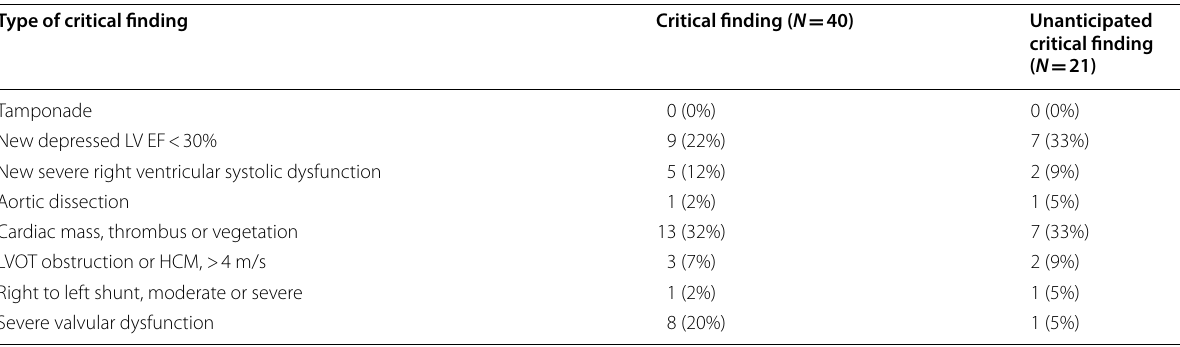
Table 1 Critical